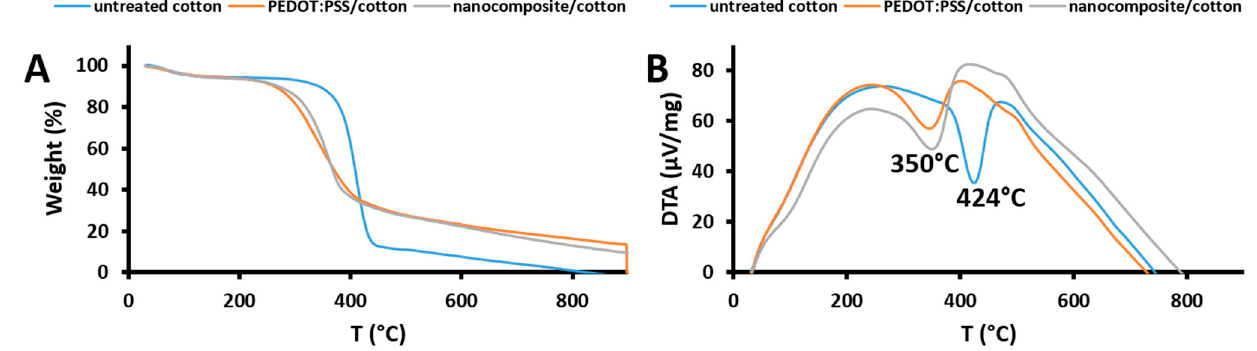
Figure 6. TGA analysis ( A ) and DTA analysis ( B ) of the untreated cotton fabric and the cotton fabrics treated with PEDOT:PSS and the nanocomposite.